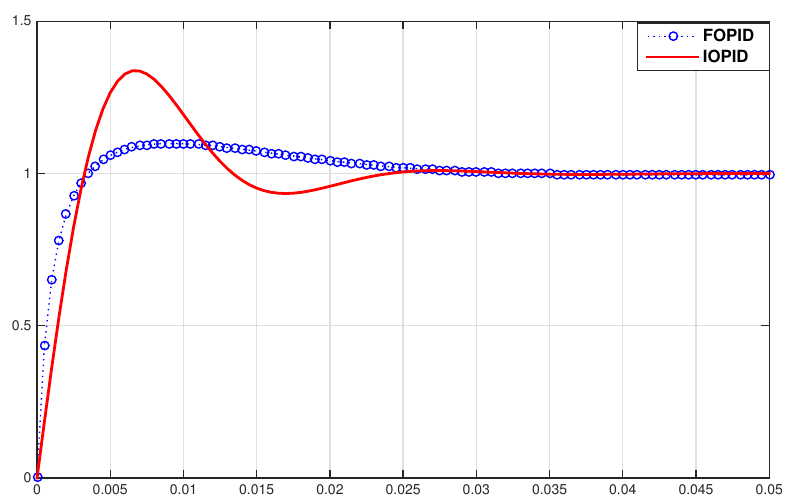
Figure 10. Step responses under the FOPID and integer order PID (IOPID)